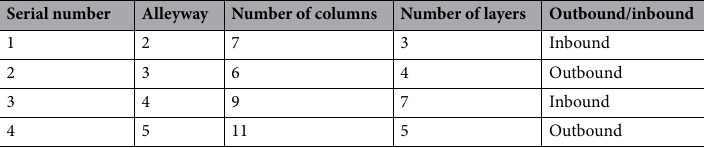
Table 4. List of outgoing/incoming